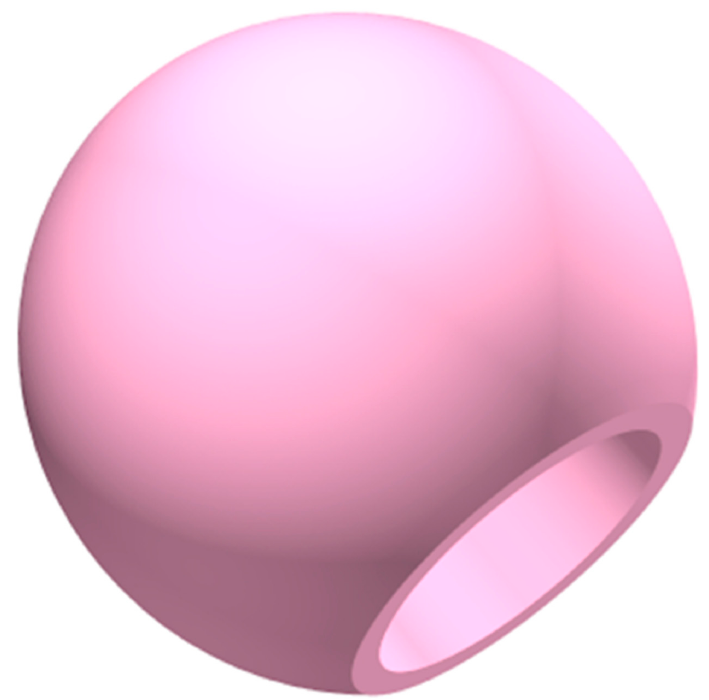
Figure 6. Biolox ® Delta femoral head.